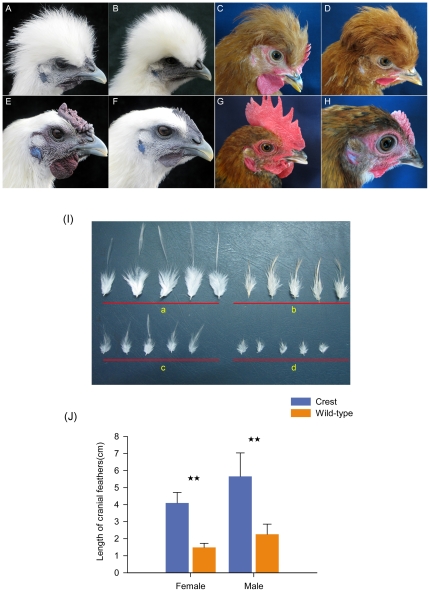
Crested and wild-type chickens.(A–D) Crest phenotype; (E–H) wild-type phenotype; (A and E) Silkie male; (B and F) Silkie female; (C) Chinese fatty chicken male; (D) Chinese fatty chicken female; (G) Chahua chicken male; (H) Chahua chicken female. (I) Overview of cranial feathers with gender indicated, sampled from 44 weeks old Silkie chickens. (a) Crested male; (b) Crested female; (c) Wild-type male; (d) Wild-type female. (J) There was a statistically significant difference in feather length between phenotypes. The number of feathers in each group obtained from three individuals were as follows: Crested male: 47; Crested female: 44; wild-type male: 100; wild-type female: 100 (**, P<0.01).